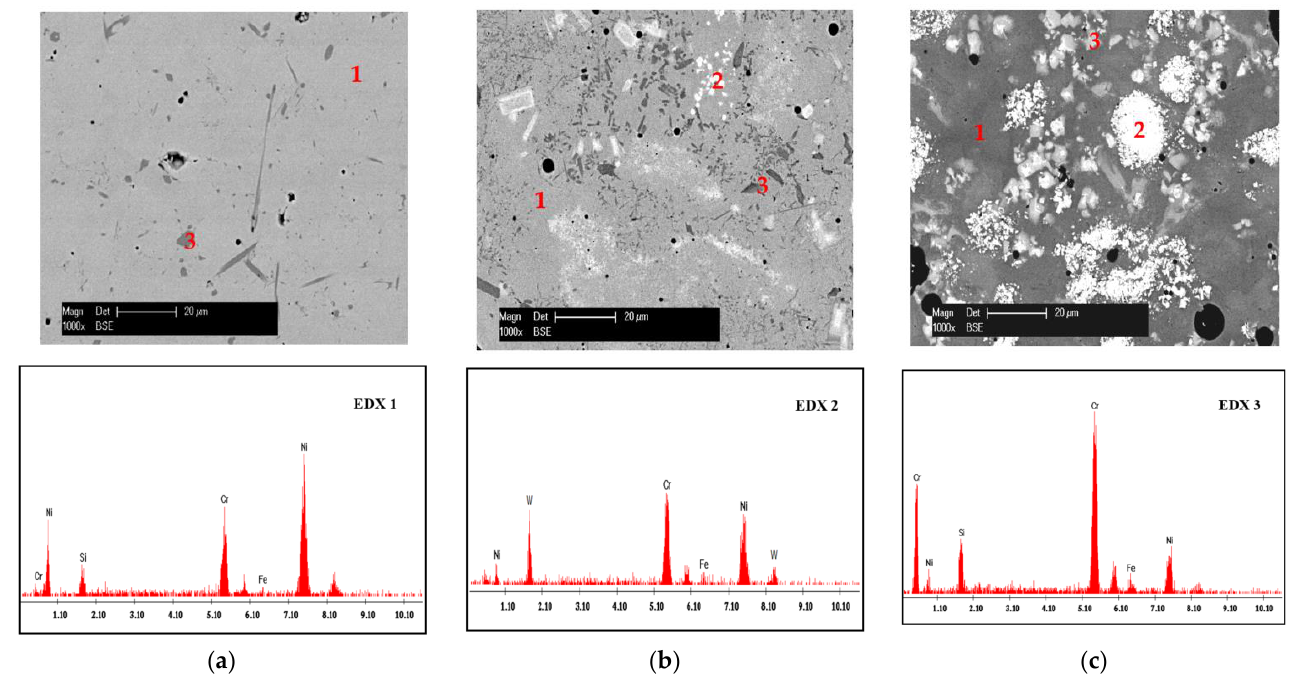
Figure 3. Cross-section SEM micrographs of the coatings at higher magnification combined with EDX analysis: ( a ) SFA; ( b ) 85/15; ( c ) 70/30.